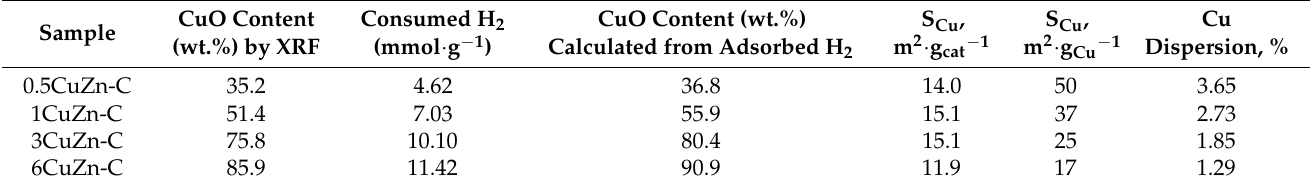
Table 3. H 2 -TPR and N 2 O chemisorption data for CuZn mixed